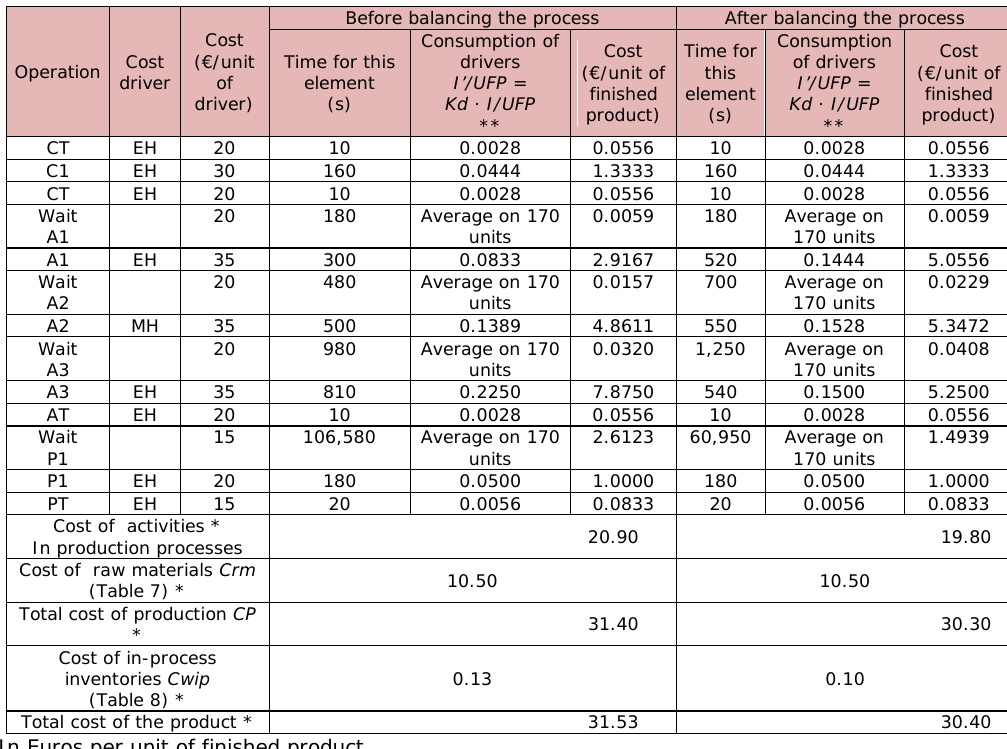
Table 9. “Calculation of the production cost, according to the costing method based on ABC”.